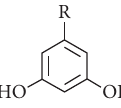
Figure 1: General structure of ARs. R-alkyl or alkenyl side chain, oxygenated R is also possible. The R position may be changed and presence of additional polyphenolic rings is possible depending on the type of organism synthesizing ARs.